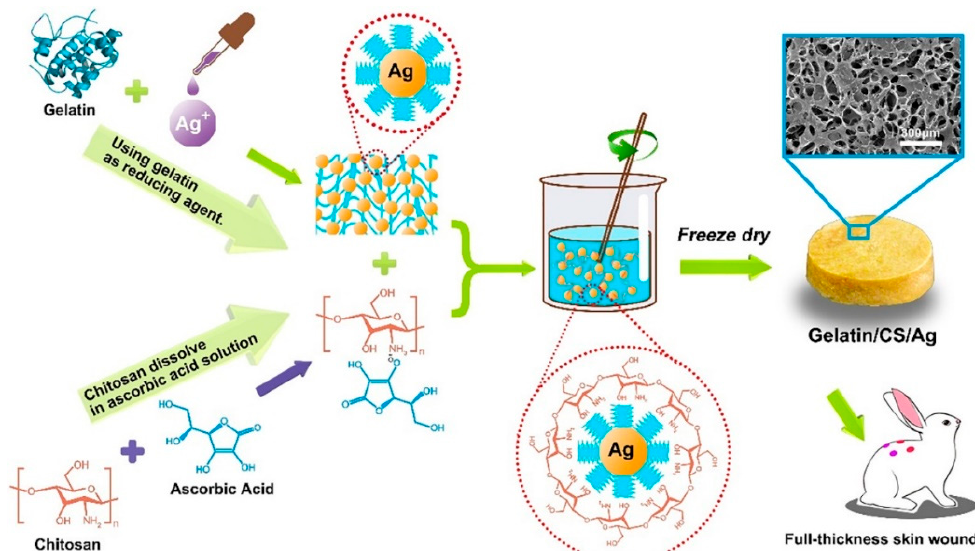
Figure 2. The preparation process and the principle of composite gelatin/CS/Ag-based composite with enhanced antimicrobial and wound-healing activity. Reprinted from Ref. [20] with permission from Elsevier. License Number: 5063250903839.